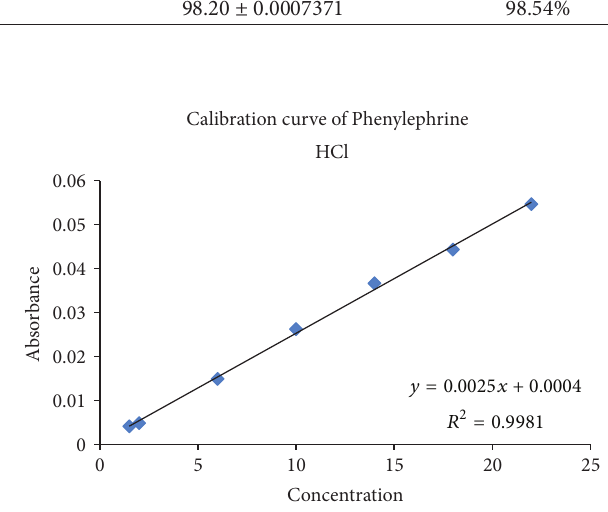
Figure 3: Calibration curve of Ibuprofen.